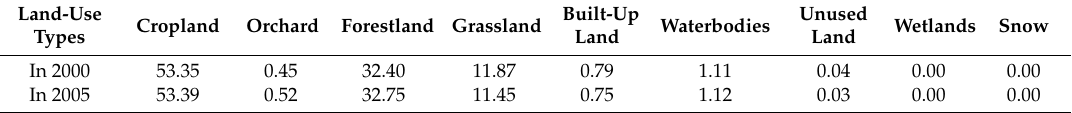
Table 3. Area of each land use type in the study area in 2000 and 2005 (unit: